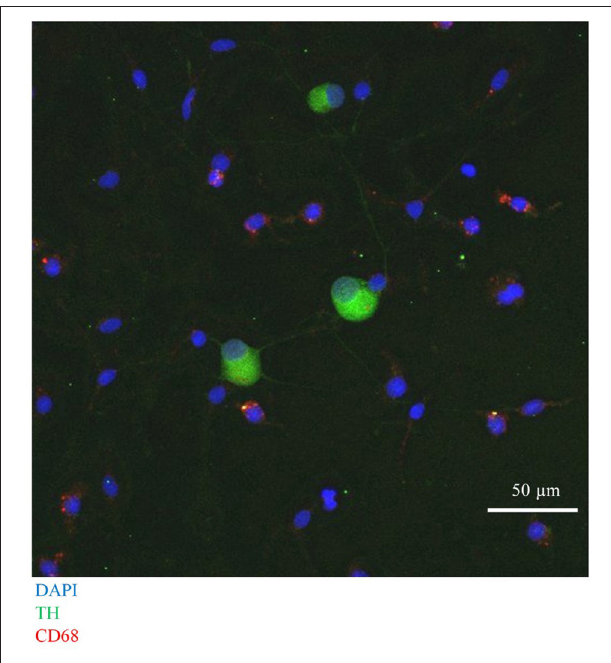
FIGURE 7 | Immunocytochemical image of Wistar stellate neurons (TH + , green), with BMDMs (CD68 + , red).